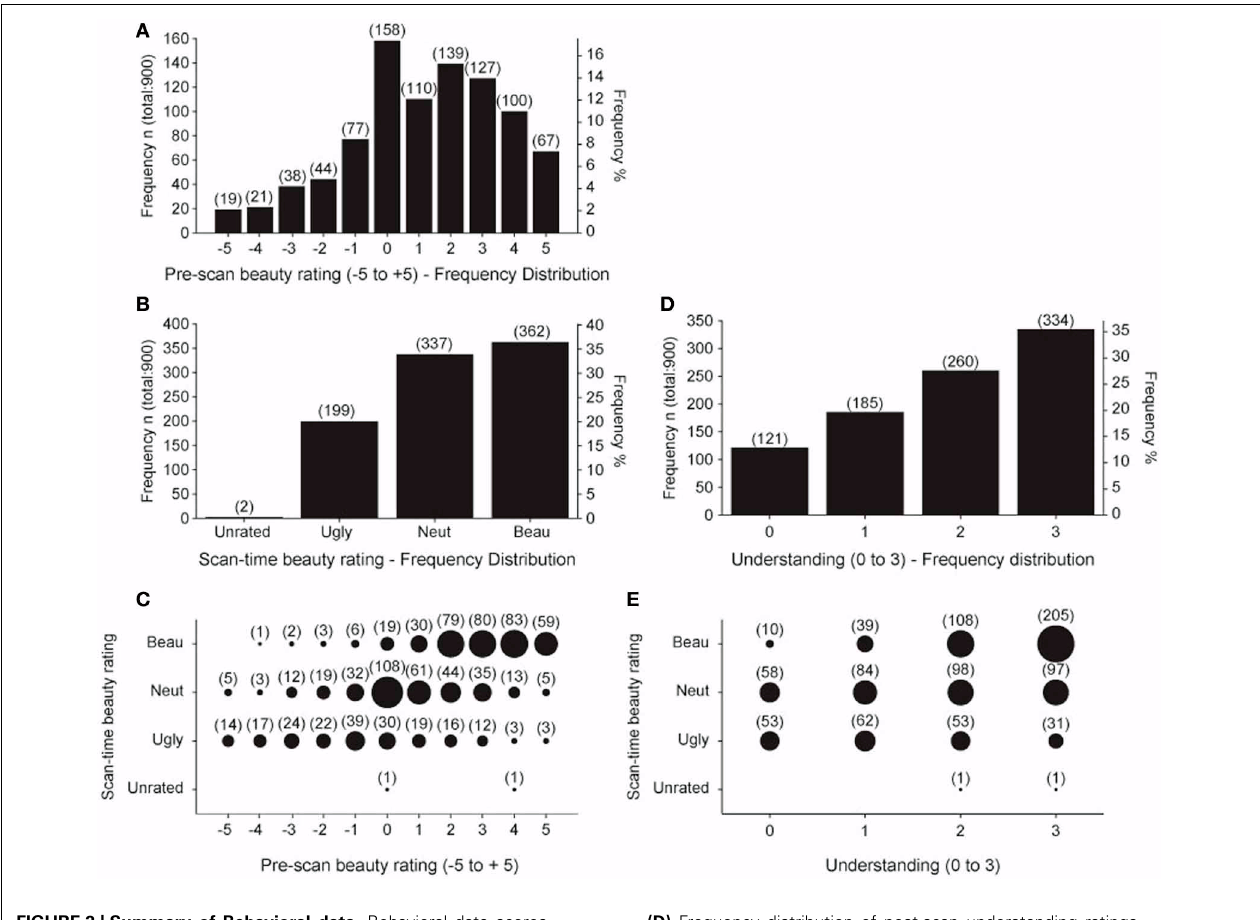
(D) Frequency distribution of post-scan understanding ratings. (E) Post-scan understanding ratings plotted against scan-time beauty ratings. Numbers in brackets give the count for each group. Area of each circle is proportional to the count for that